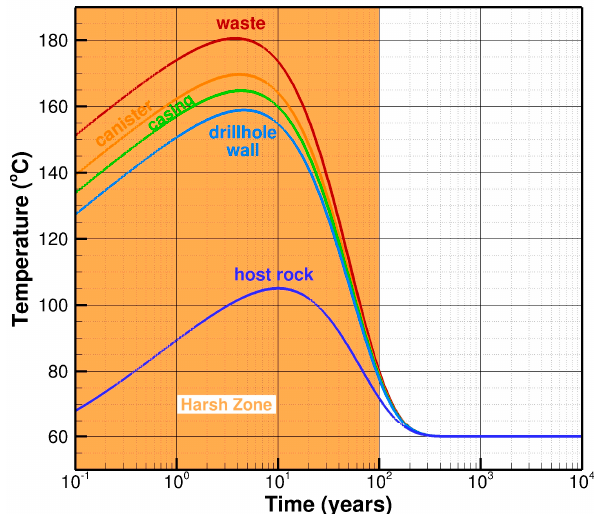
Figure 3. Evolution of temperature change for an initial heat release of 100 W per waste capsule with capsule spacings of 2 ft (0.6096 m) [27].